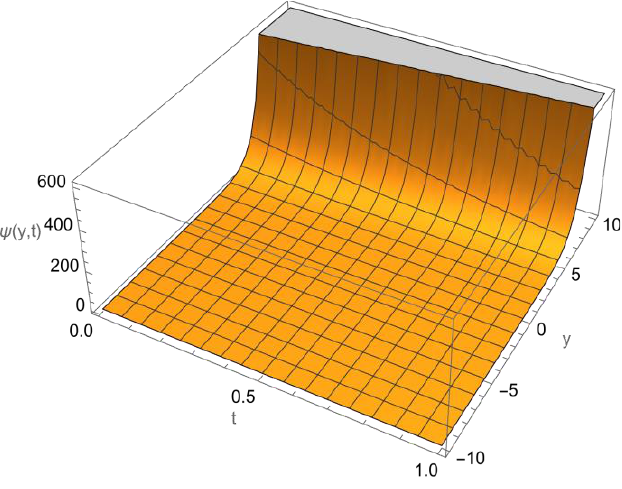
Figure 6. Exact solution ψ ( y , t ) of Example 6.